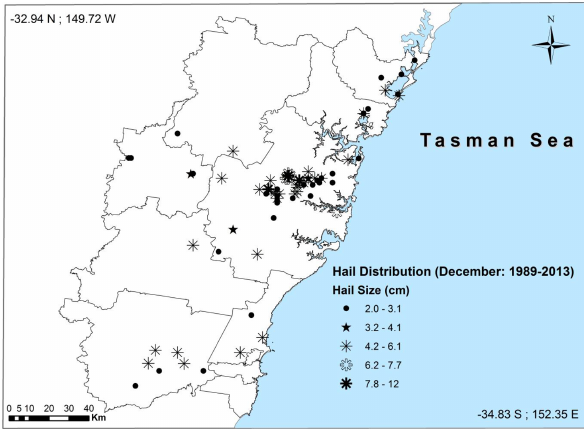
Figure 7. Spatial distribution of hail events during December with the maximum observations recorded inside the study